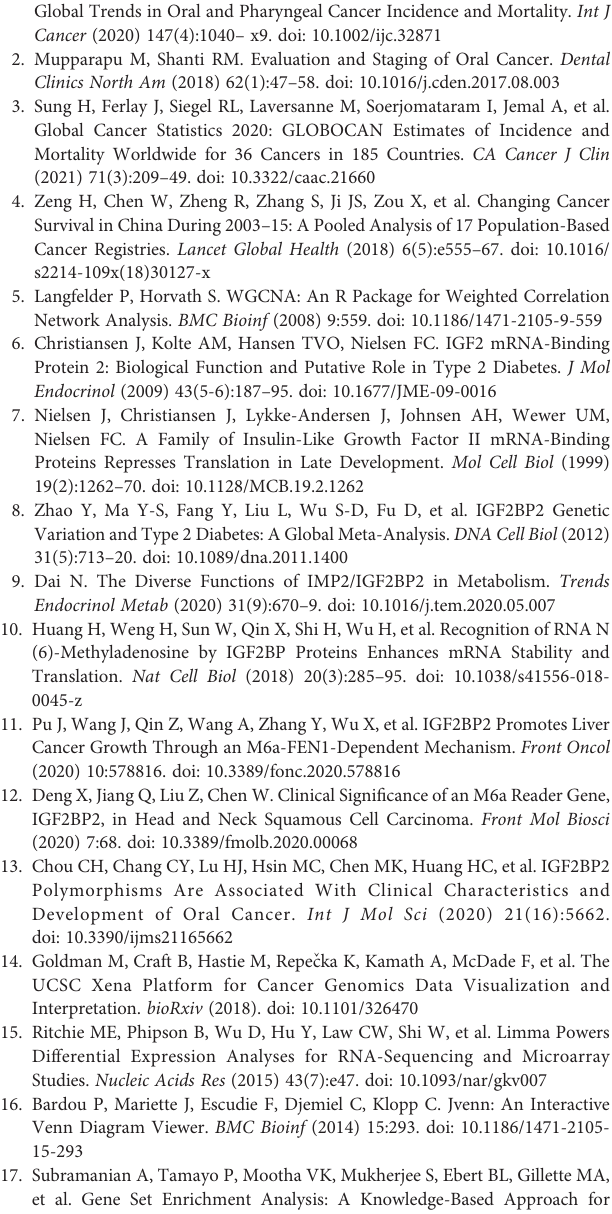
Supplementary Data Sheet 5 | Enriched Hallmark gene sets based on IGF2BP2 expression in TCGA-OSCC dataset. Supplementary Data Sheet 6 | Enriched KEGG gene sets based on IGF2BP2 expression in TCGA-OSCC dataset. Supplementary Data Sheet 7 | Enriched Hallmark gene sets based on IGF2BP2 expression in the GSE30784 dataset. Supplementary Data Sheet 8 | Enriched KEGG gene sets based on IGF2BP2 expression in the GSE30784